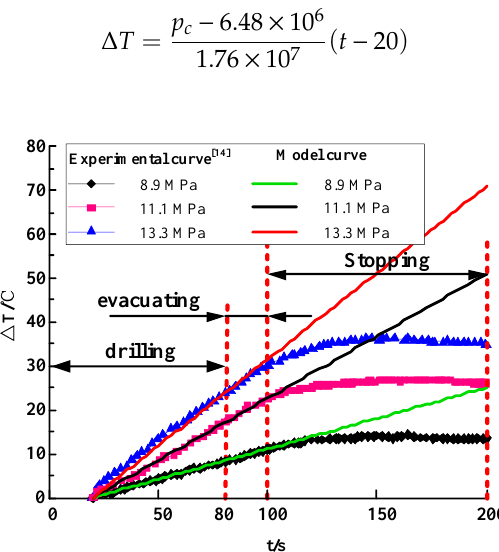
Figure 9. Fitting diagram of temperature variation of bit.